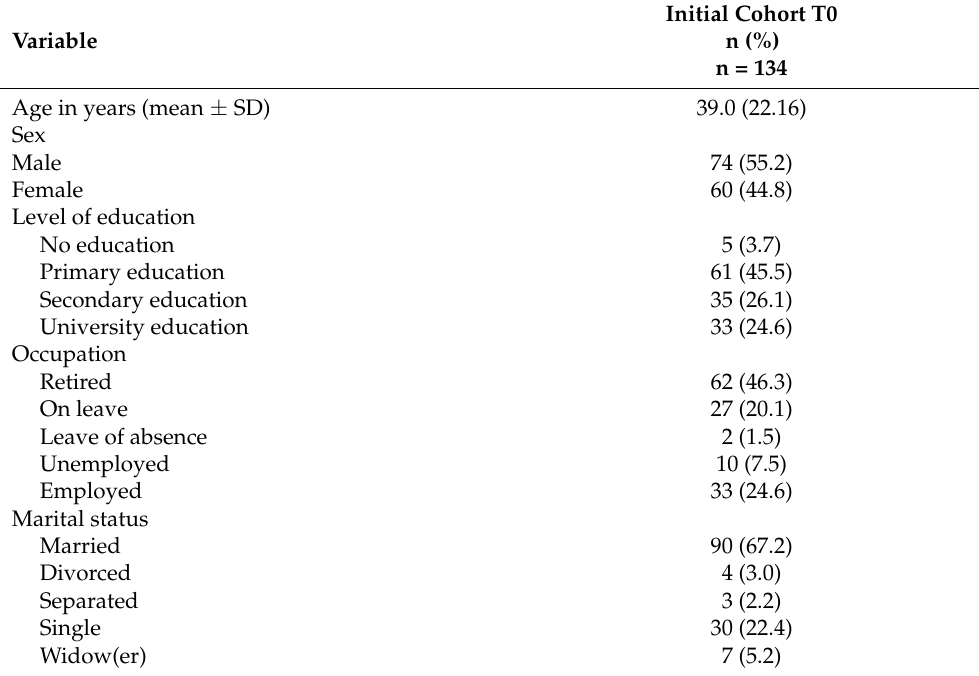
Table 1. Sociodemographic characteristics of the participating